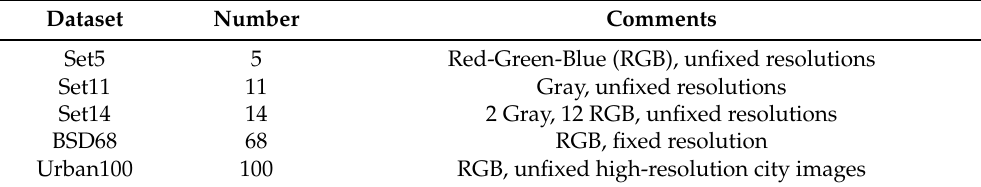
Table 1. Summary of